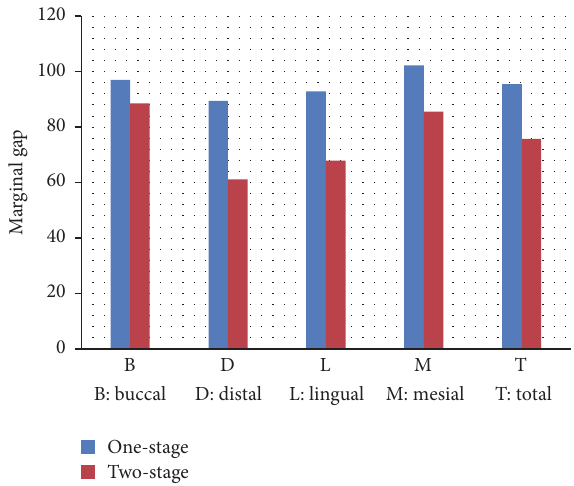
Figure 1: Comparison of the means of marginal gaps for one- and two-stage impression